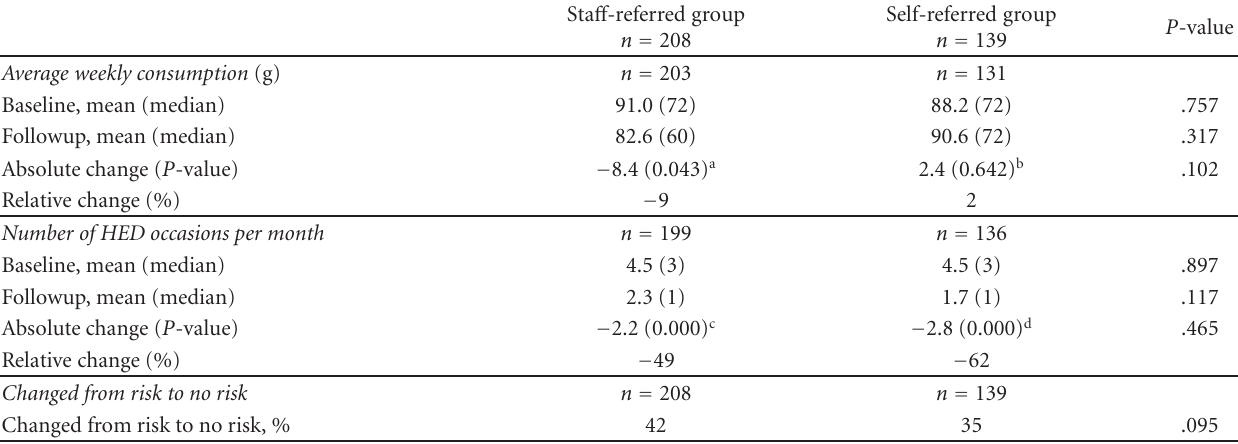
Relative change (%)